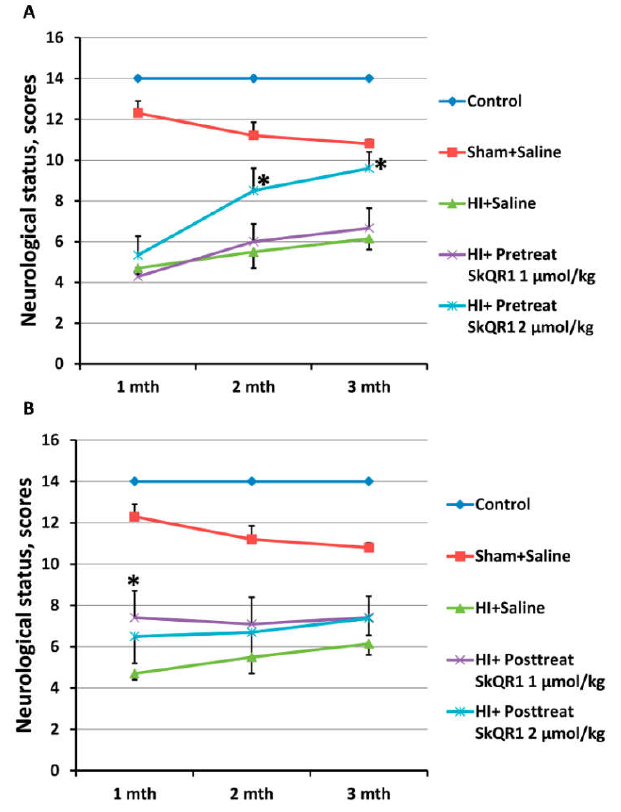
Figure 4. Effect of mitochondria-targeted antioxidant SkQR1 on neurological status determined by a limb-placing test on first, second, and third month after HI. SkQR1 was administrated i/p 24 h before HI ( A ) or 10 min after start of reoxygenation ( B ) at doses 1 and 2 µmol/kg. Data is expressed as mean ± SEM * p < 0.05 denotes significant difference from HI + Saline group (Kruskal–Wallis test with the Mann–Whitney u -test).